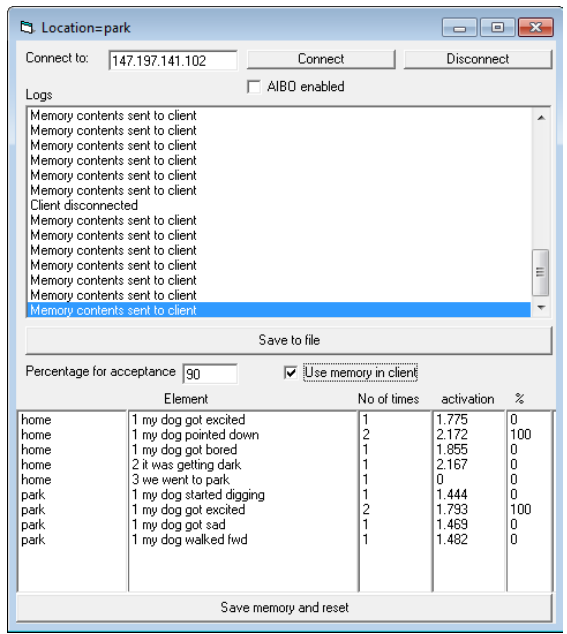
Figure 3. The server application with the memory list.